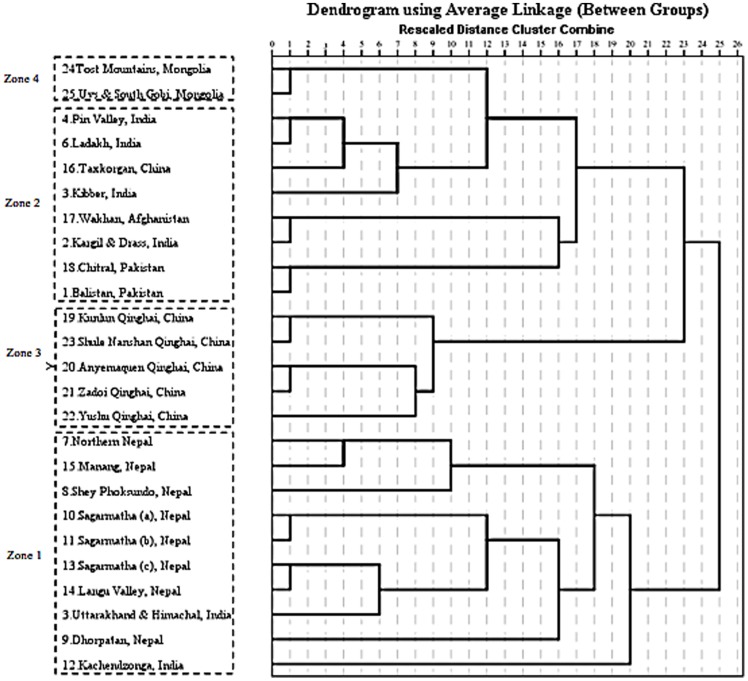
Zonation dividing the four zones using Yule ‘Y’ colligation co-efficient.Bases on potential prey available in study areas of referred. Clusters formed in to 4 zones based on potential prey (1-0 matrix) available in the study site. Nearest linkage are close to 0 farthest are towards 25. On average groups were at 25 and 20 (Zone 1), 9 (Zone 3), 23, 17 (Zone 2), 8 and 1 (Zone 4). Zone 4 separated out as a sub cluster but due to it's physiographical nature this zone is treated as distinct.